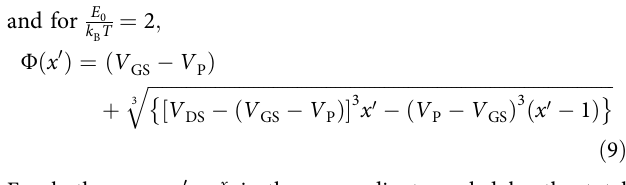
length of the channel L .